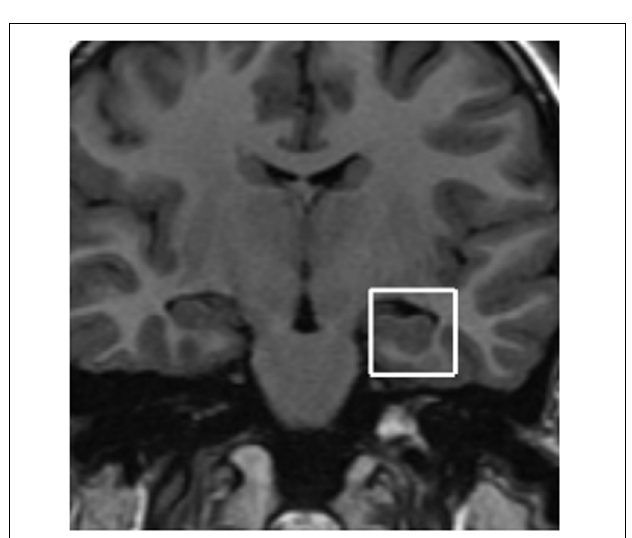
FIGURE 2 | Proton spectra was obtained from a voxel 2 × 2 × 2cm prescribed from a coronal plane. Four MRS VOI prescriptions were made for each child: two on medial hippocampal regions (right and left hemisphere